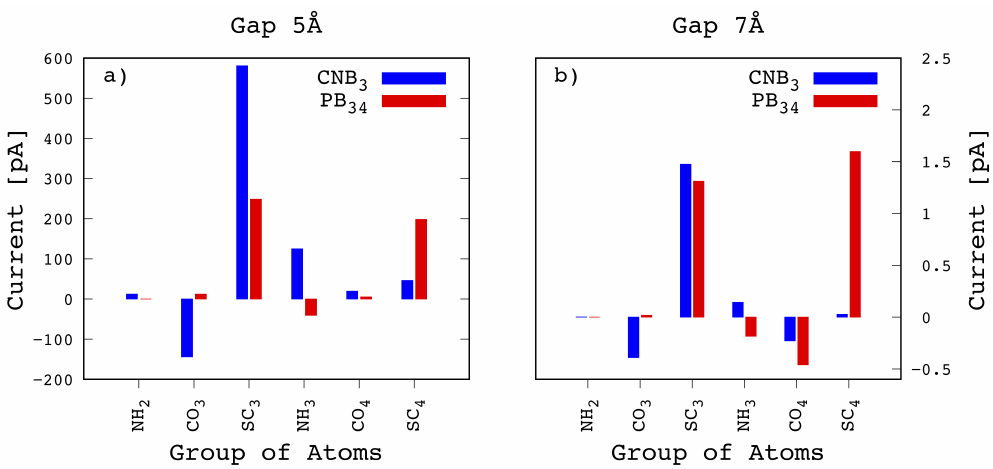
Figure 6. Bond current decomposition of CNB 3 and PB 34 configurations for two different gap sizes 5 Å ( a ) and 7 Å ( b ). For the narrowest gap, the injection into the SC 3 for CNB 3 is very large, being also larger than the sum of the injection into SC 3 and SC 4 for PB 34 . For the widest gap the injection into the SC 3 groups drops for CNB 3